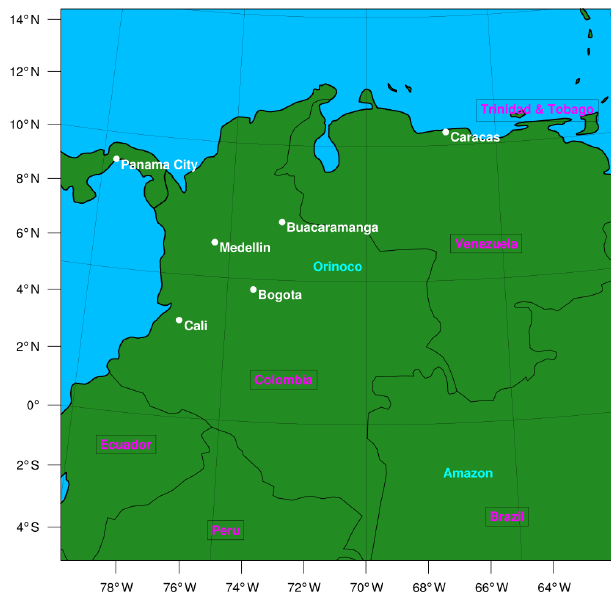
Figure 1. WRF-Chem domain including countries (pink), major cities (white) and regions